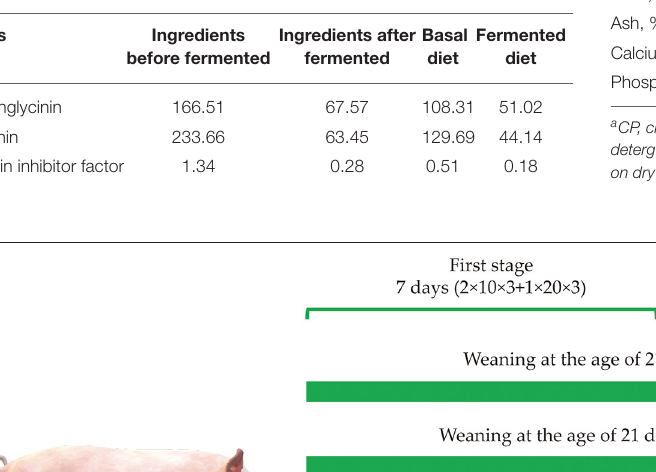
Ingredients after Basal Fermented fermented diet diet